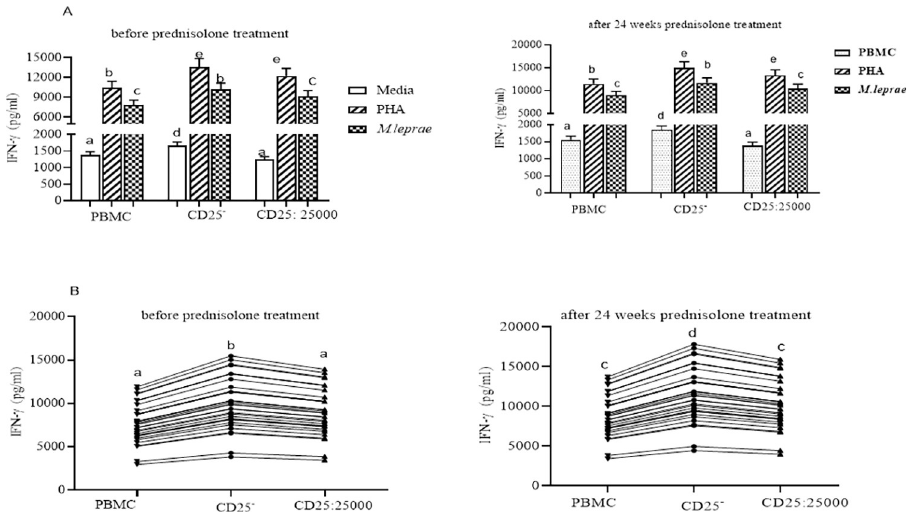
Fig 5. The effect of depletion of CD25 + cells on IFN γ secretion by PBMC from ENL participants (n = 30): (Fig 5A) IFN γ response to PHA and M . leprae WCS stimulation before and after 24 weeks of prednisolone treatment; (Fig 5B) IFN γ response to M . leprae WCS stimulation in control PBMC, CD25 + depleted PBMC and autologous CD25 + cells added PBMC to CD25 + depleted PBMC from individuals with ENL before and after 24 weeks of prednisolone treatment. Each bar and line graphs show mean ± 95% confidence interval (CI). Any pair of different letters shows that the mean of IFN γ production of the two groups are statistically significantly different at p = 0.05 and any pair of similar letters indicates that the mean of IFN γ production the two groups are not statistically significantly different at P � 0.05 and 95% CI. Media indicates AIM-V medium only which was used in the assay as negative control with PHA used as a positive